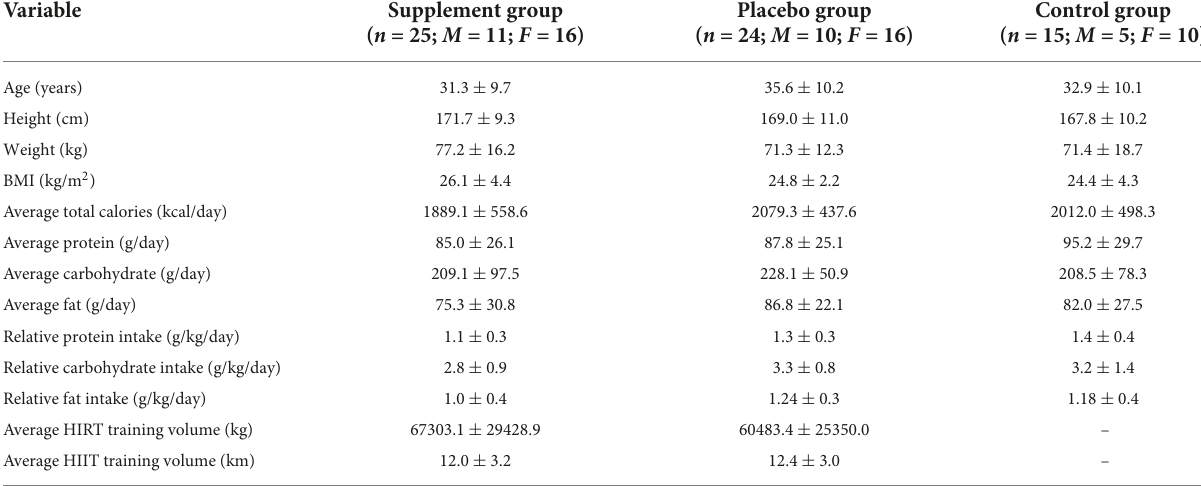
TABLE 1 Participant characteristics presented as mean ± standard